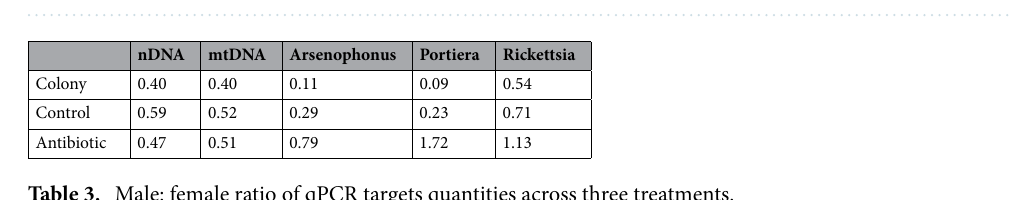
Figure 7. Relative quantification of Arsenophonus across the treatment groups. Figure on the right represents quantities after normalization to the nuclear DNA, while the figure on the left shows the data without normalization. In both cases, ANOVA was performed on the Box Cox transformed data. Within one figure, values with the same letter are not significantly different (alpha = 0.05, Tukey’s HSD test). Note that the relative quantity (y-axis) is shown on the original, not transformed scale for more intuitive interpretation. Definition of the boxplot is the same as in the Fig. 3.